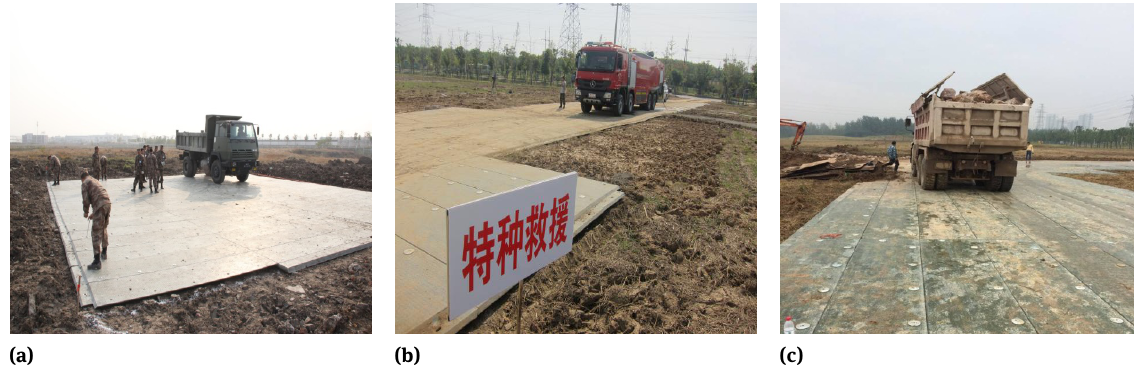
Figure 13: Application of paulownia wood core composite sandwich matting: (a) military engineering, (b) emergency rescue, (c) oil, natural gas and coal mine